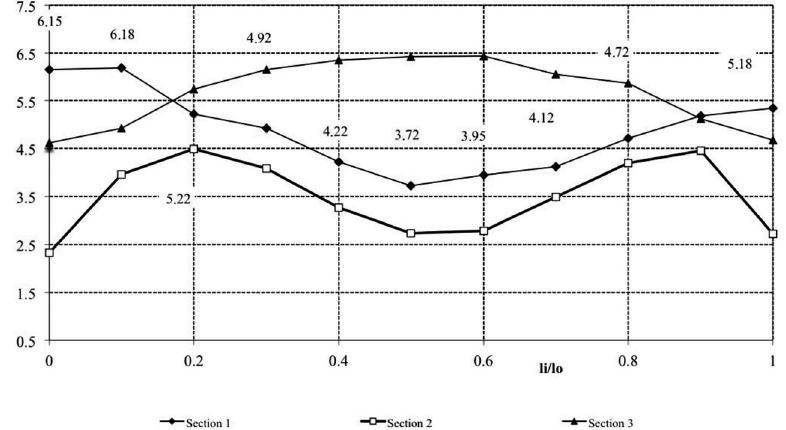
Figure 7: Distribution of Λ on the longitudinal section of workpiece at a broach in flat baizes with relative giving of 1.0 (section 1 – D i / D ¼ 0.9; section 2 – D 0 D – length and diameter of the deformation center, 0